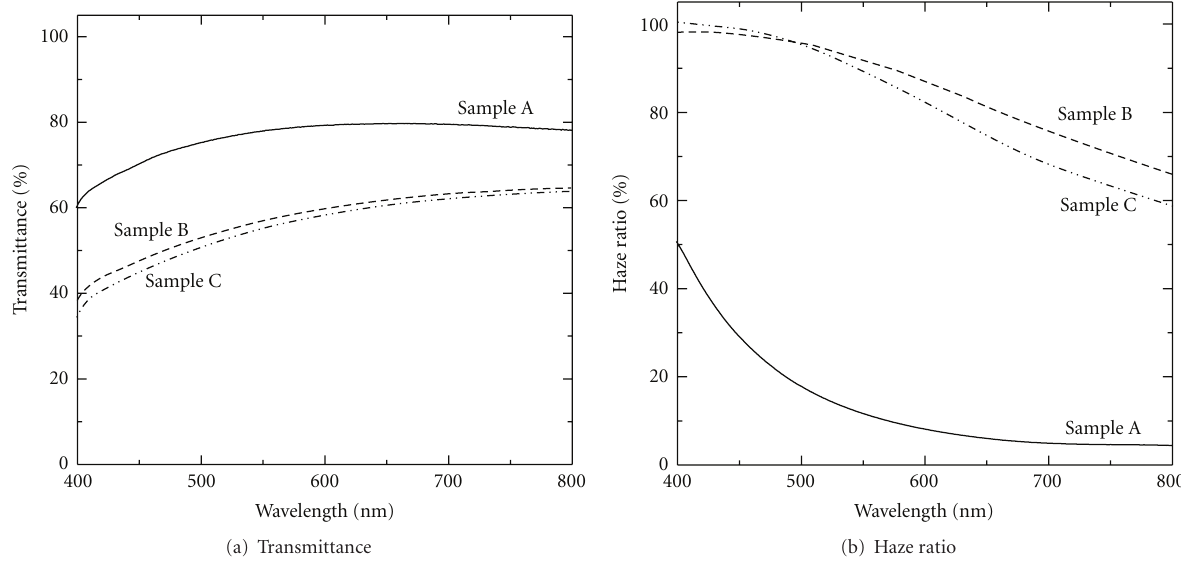
Figure 6: (a) Transmittance and (b) haze ratio for TiO 2 -coated layers from UV-vis measurements.